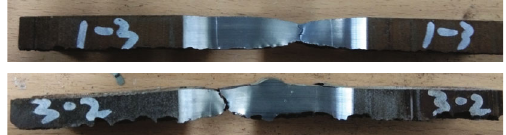
Figure 14: Images of the specimens and surface topography of the specimens with di ff erent corrosion